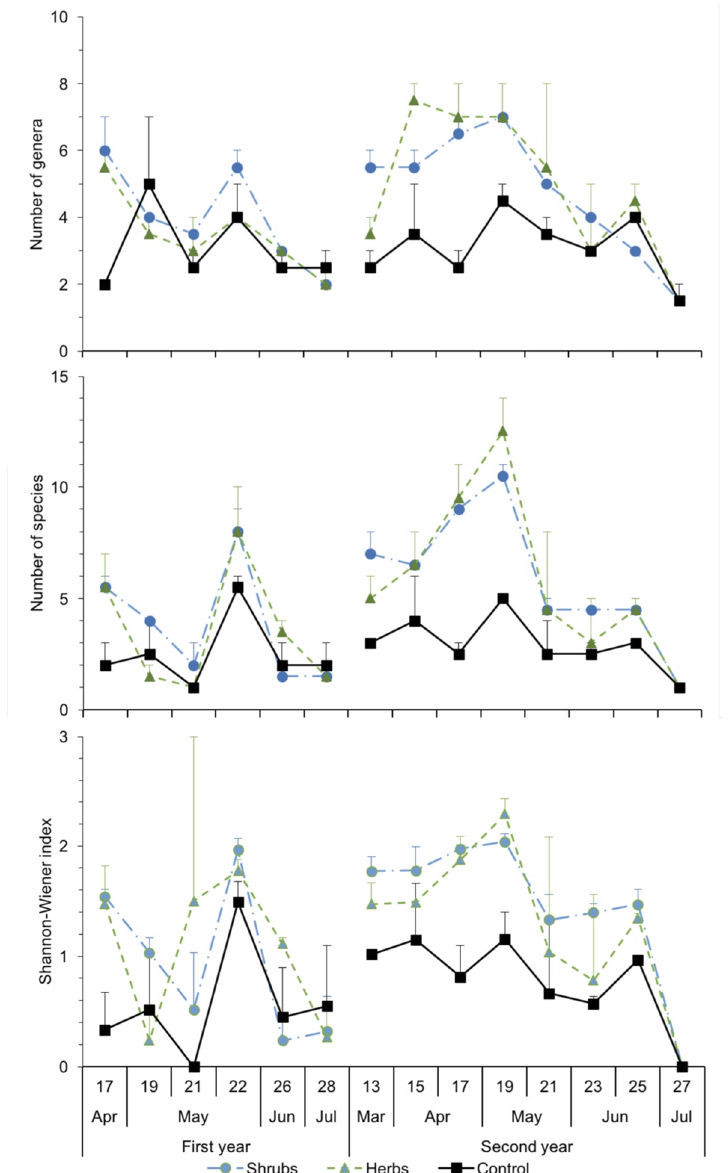
Figure 1. Numbers of genera (upper chart) per margin type on each sampling date and species (central) and the Shannon-Wiener index (lower) in pan traps in shrubby, herbaceous and control margins (means±SE). The numbers in the abscise (x) axe indicate the week of the year.